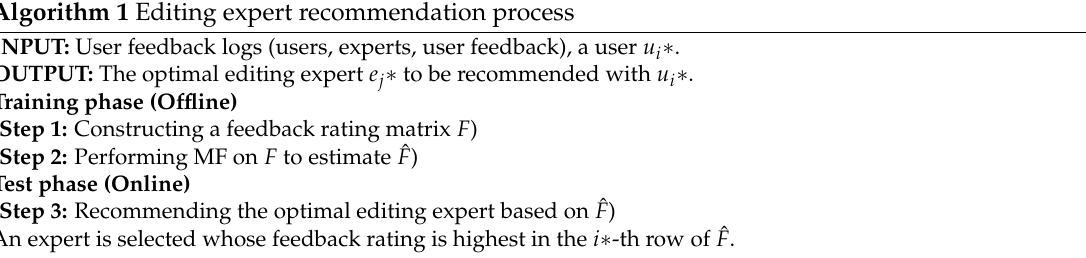
Algorithm 1 Editing expert recommendation